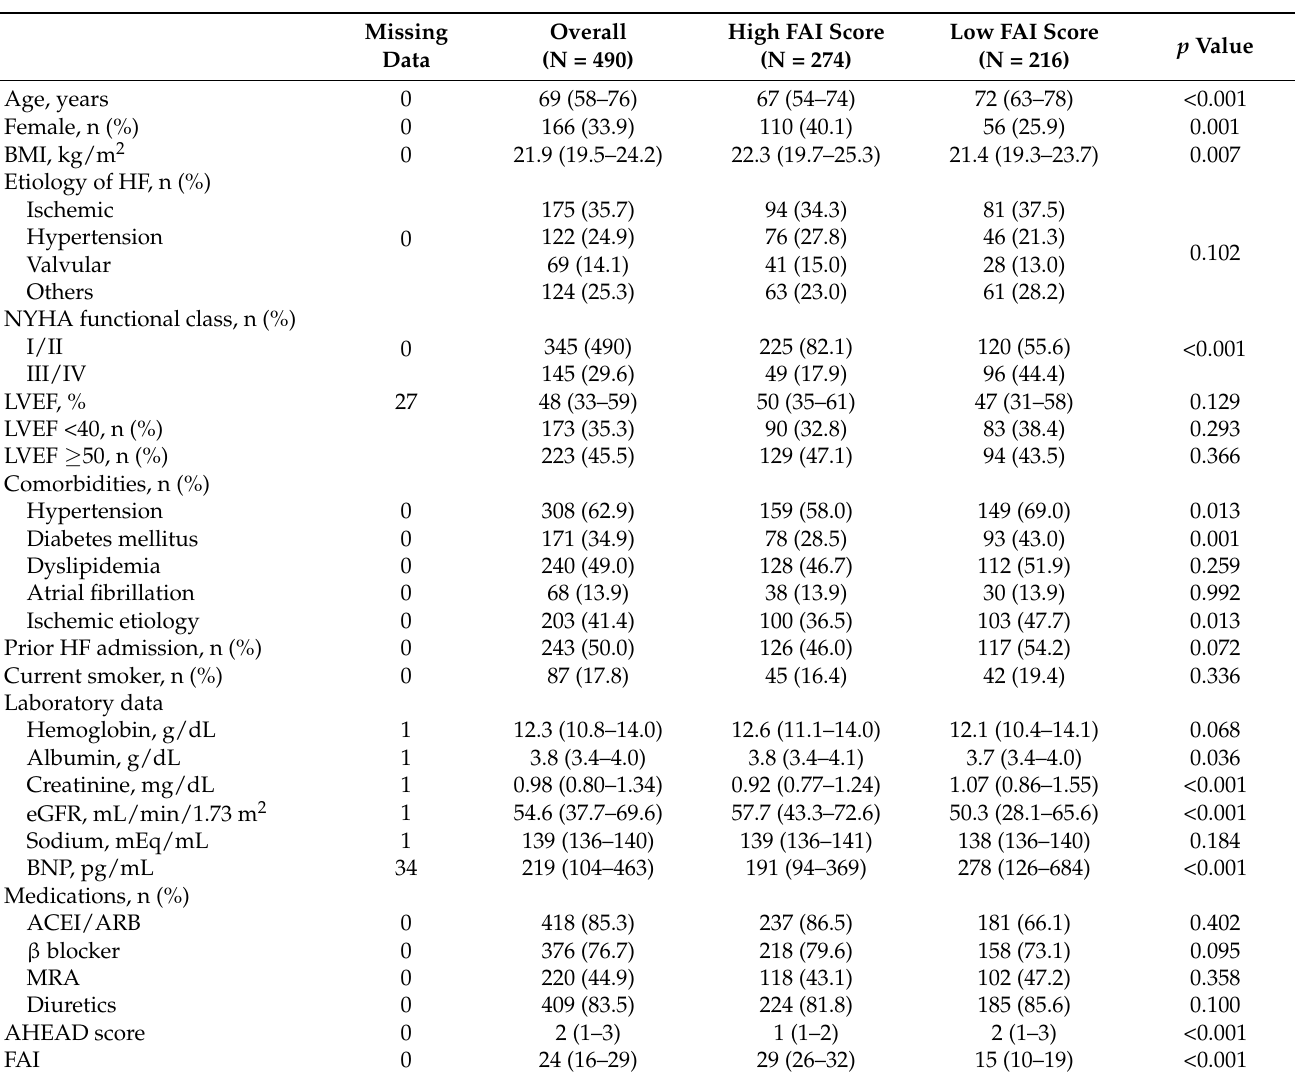
Table 1. Patient